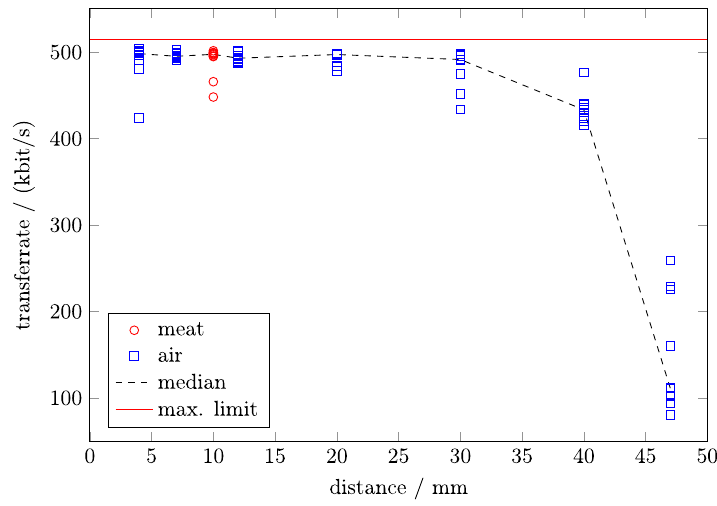
Figure 5. Data transfer rates for different distances.